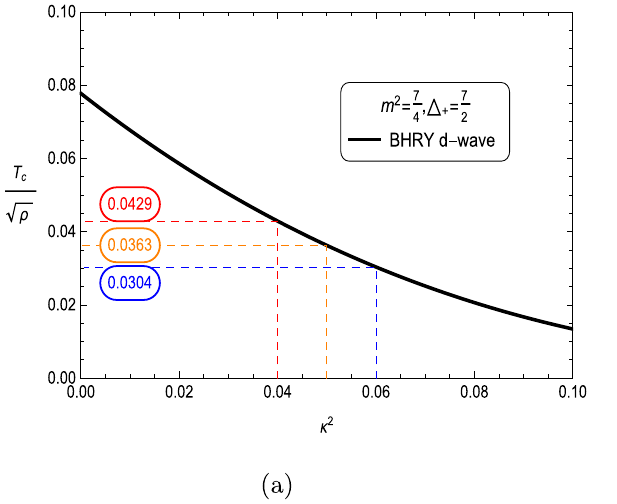
and the critical temperatures are T c / √ ρ = 0 . 0363 (orange: κ 2 = 0 . 05) and T T c / κ 2 = 0 . 04) respectively. The condensate goes to zero at T = T